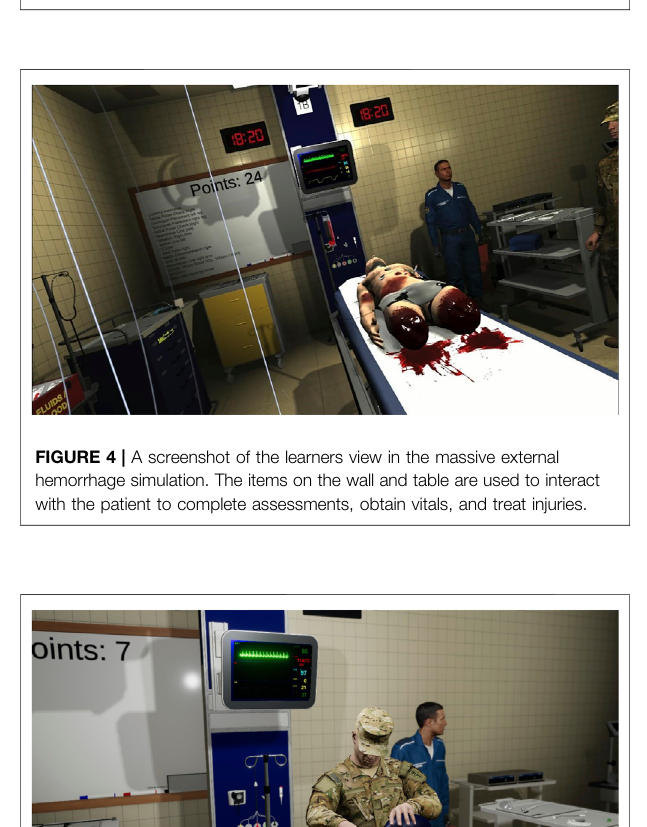
Frontiers in Virtual Reality |